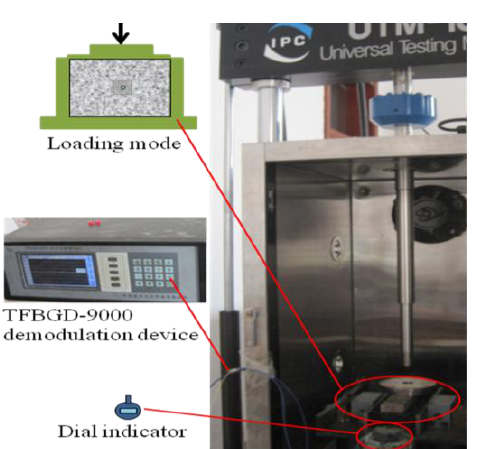
Figure 6. System loading